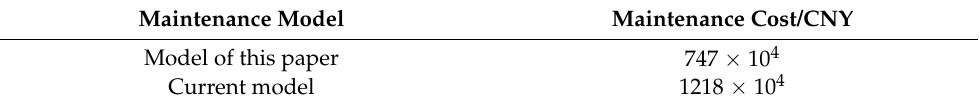
Table 4. The total cost comparison results of the power supply module maintenance